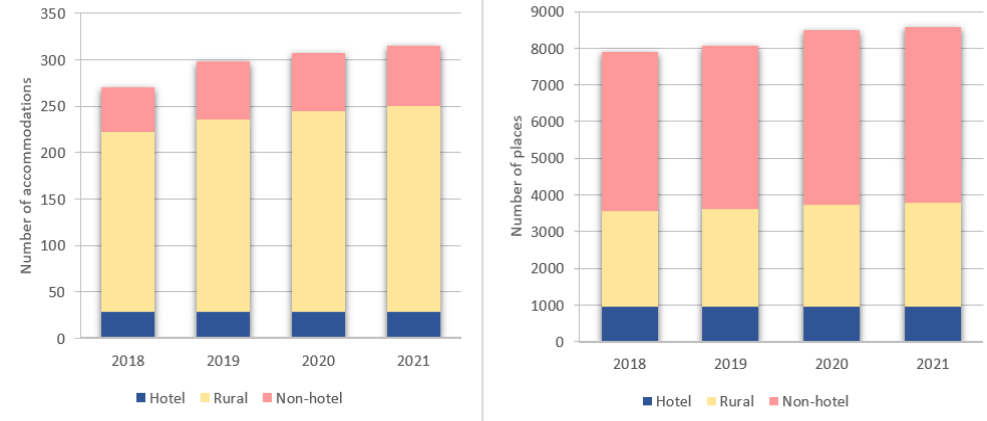
Figure 9. Graphs of the distribution of the number of accommodations and bed places offered by typology.